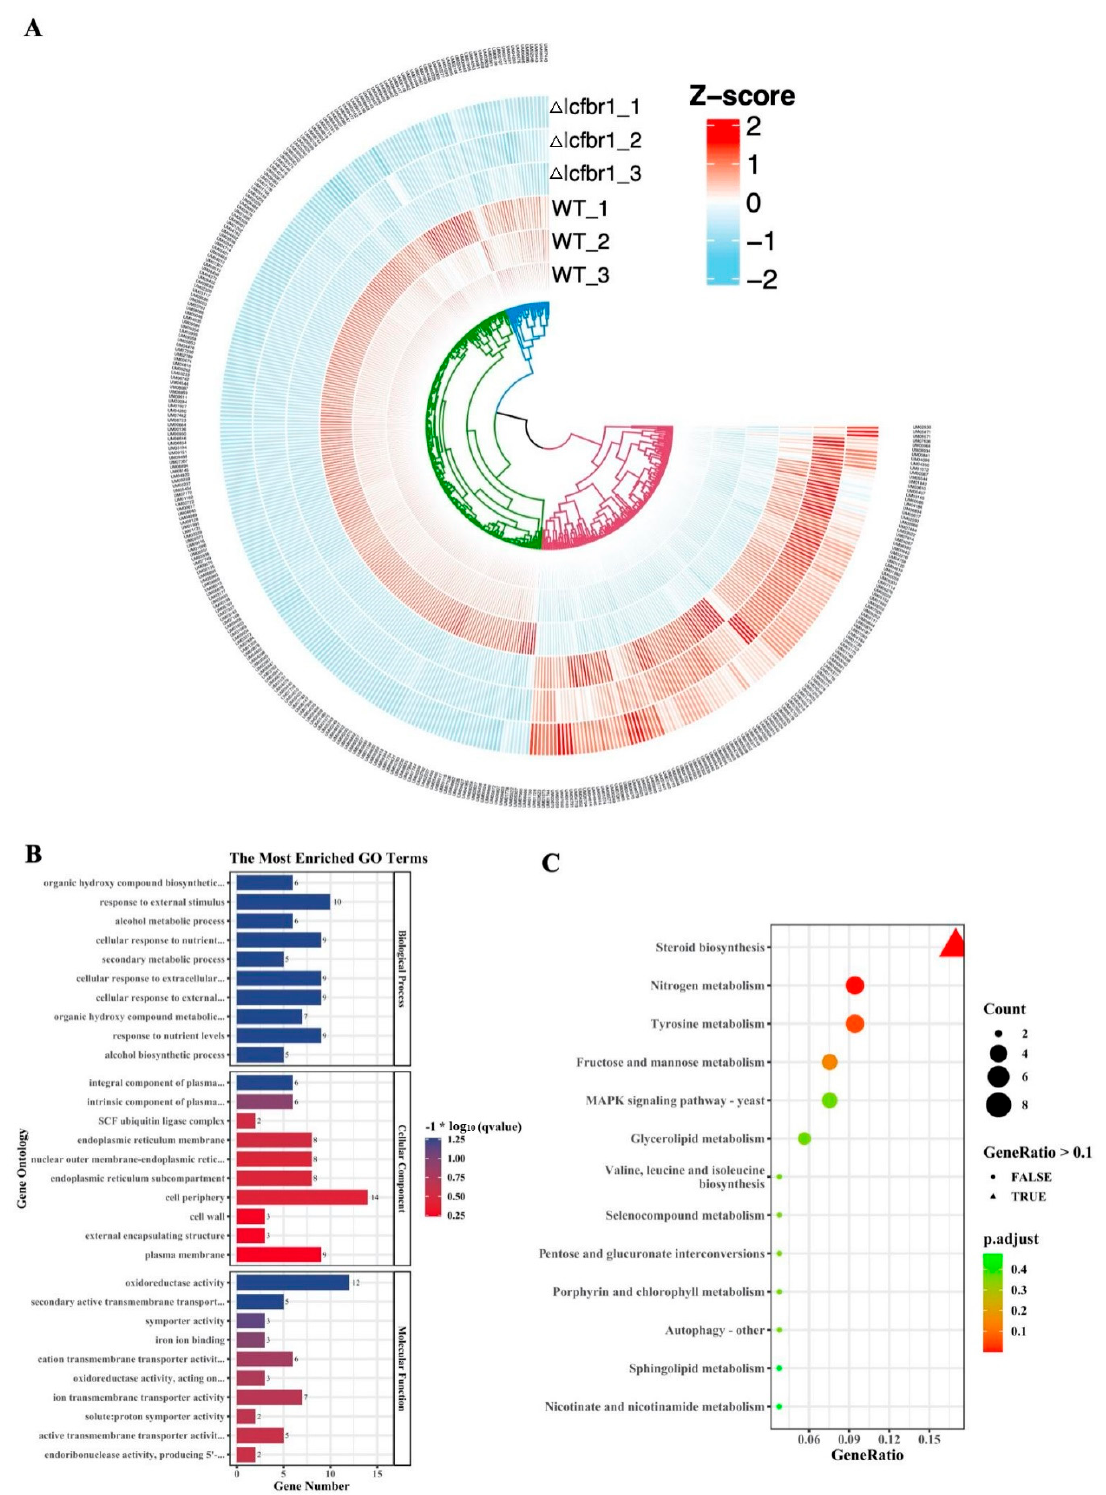
Figure 7. Transcriptome analysis of differentially expressed genes (DEGs) in ∆ Icfbr1 . ( A ) Heatmap of RNA-Seq expression z-scores computed for genes that are differentially expressed (p adj < 0.05, |log 2 (foldchange)| > 1) between ∆ Icfbr1 and wild type; ( B ) Gene Ontology (GO) enrichment analysis of DEGs between ∆ Icfbr1 and WT. The X-axis represents the number of genes in a category, and the Y-axis represents the GO term; ( C ) Scatter plots of KEGG pathway enrichment statistics based on a statistical analysis of DEGs in ∆ Icfbr1 .